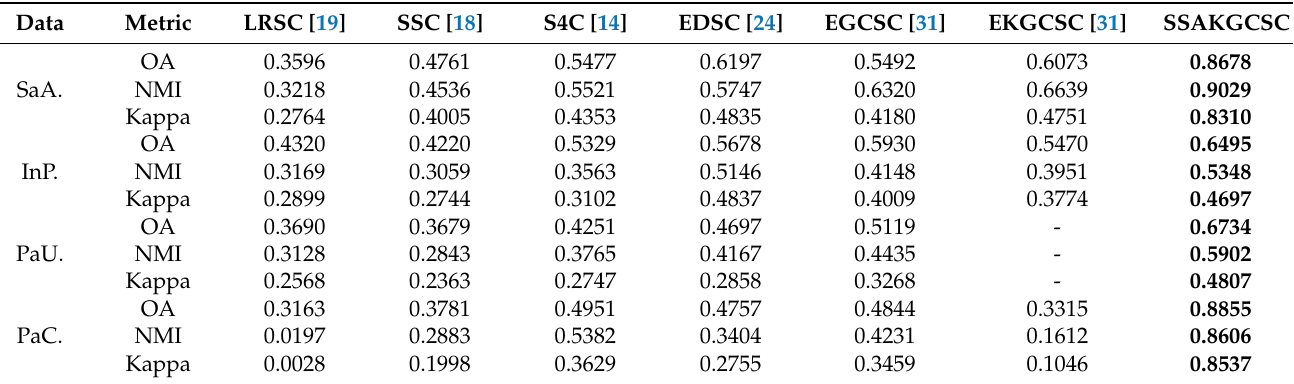
Table 5. Clustering performance of the compared methods on SalinasA, Indian Pines, Pavia Univer- sity, and Pavia Center data sets with Gaussian noise (the mean is 0 and the variance is 0.2).